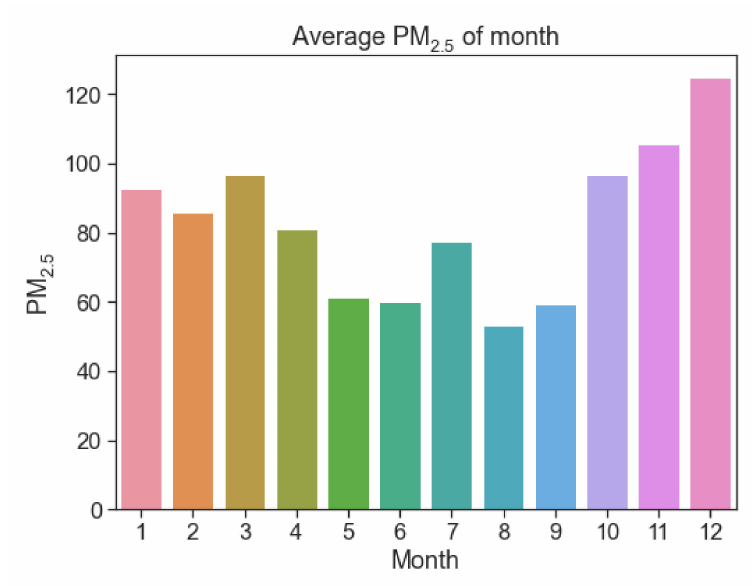
Figure 6. Average concentration of PM 2.5 in different months.